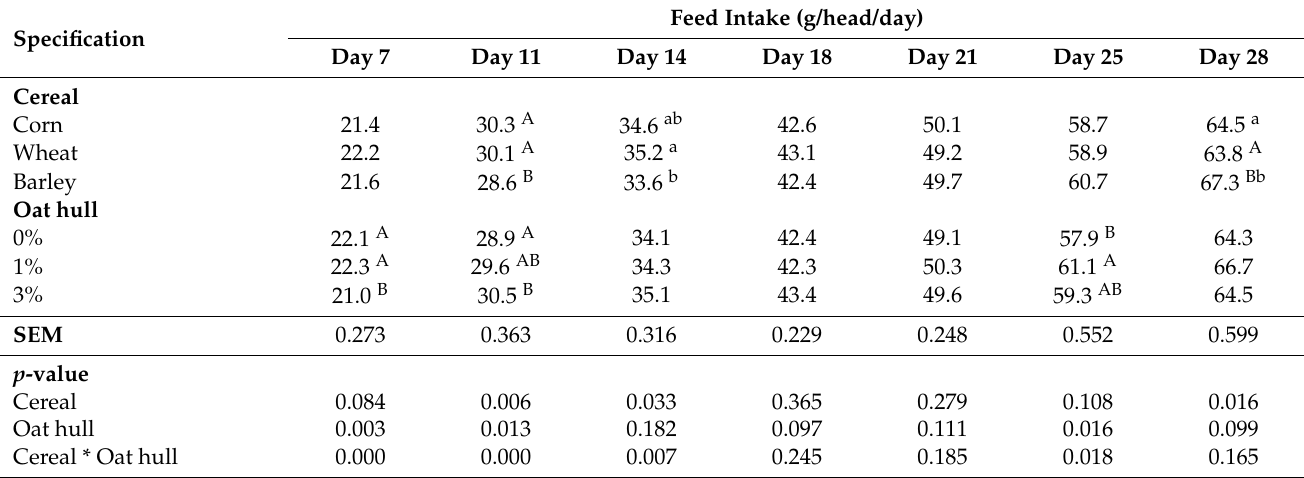
Table 4. Feed intake of broiler chickens.